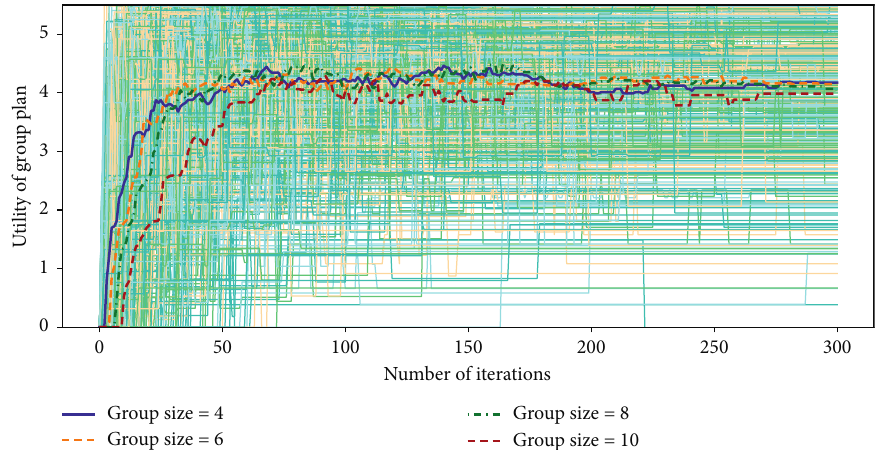
Figure 10: The changes of the utility of group plans during discussion. Thin lines show results from 100 independent runs for each group size, while the thick lines show their medians. Note that we set the initial group plan as [ 0 , 0 ] in the problem